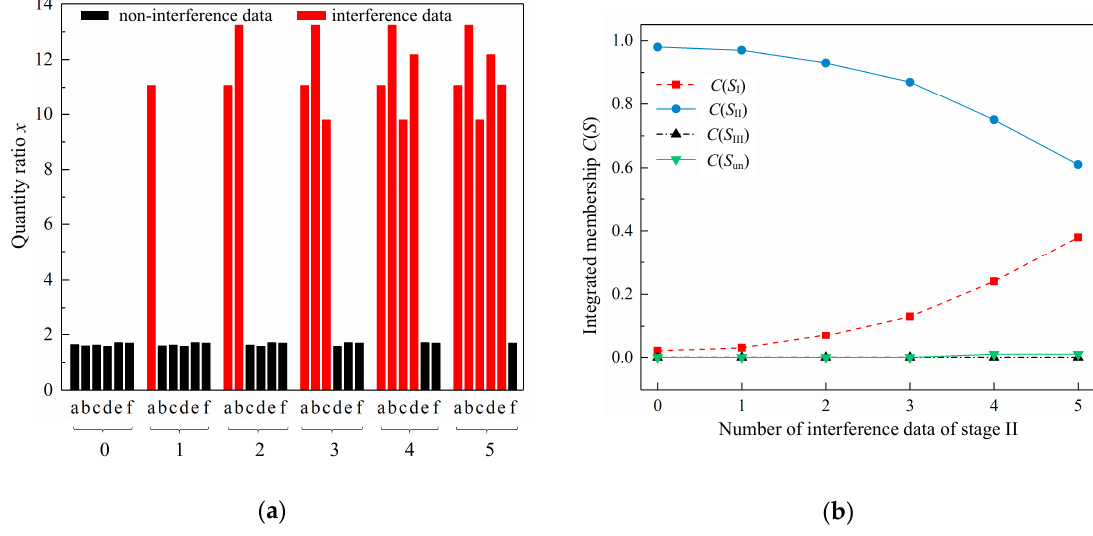
Figure 8. Performance of the model fusing different numbers of interference data of Stage II: ( a ) Quantity ratios of Methanosaeta to Methanobacterium of Stage II with different numbers of interference data (For the x-coordinate, letters a to f represent the six paralleling data, numbers 0 to 5 represent the number of interference data.) ( b ) Integrated memberships of Stage II with different numbers of interference data. (Stage I stands for the state of sludge samples after treated by centrifugal thickening and pre-dewatering, Stage II stands for the state of sludge samples after treated by thermal hydrolysis, Stage III stands for the state of sludge samples after experiencing anaerobic digestion, and stage uncertain stands for the uncertainty of the processing stage affiliation of a sludge sample.)